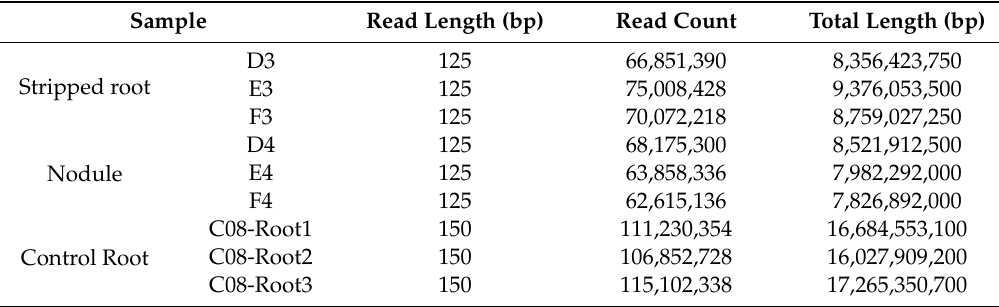
Table 1. Summary of RNA-seq sequencing